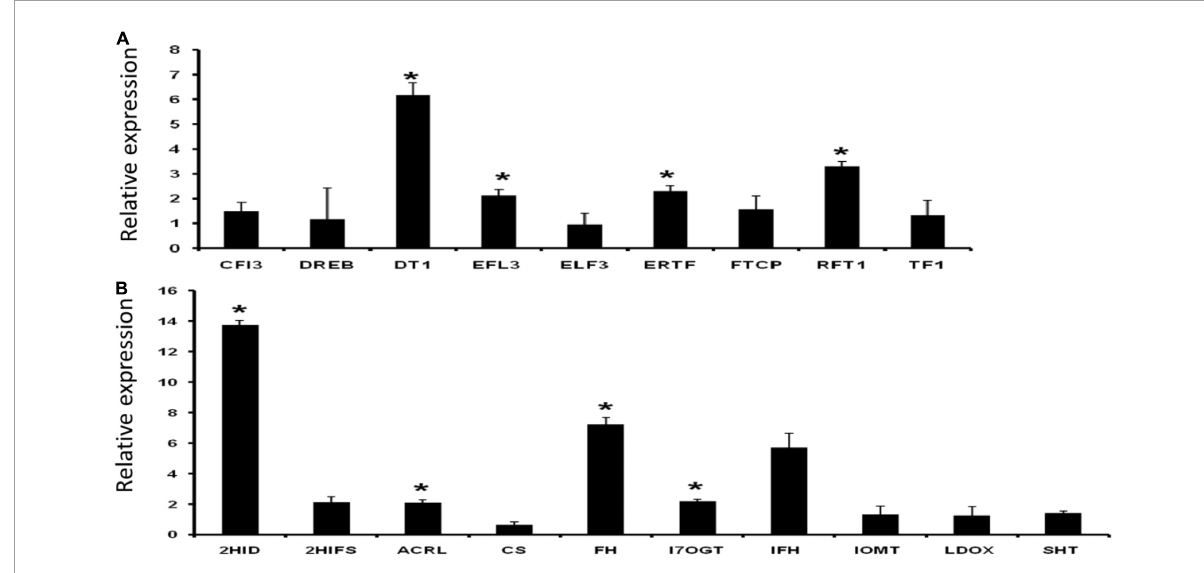
FIGURE10 Relative expression of panels (A) flowering and (B) palatability related genes. Data represent the mean ± SE of 3 replications. Columns marked with an asterisk indicate statistically significant changes, as determined by Student’s t -test (* p <